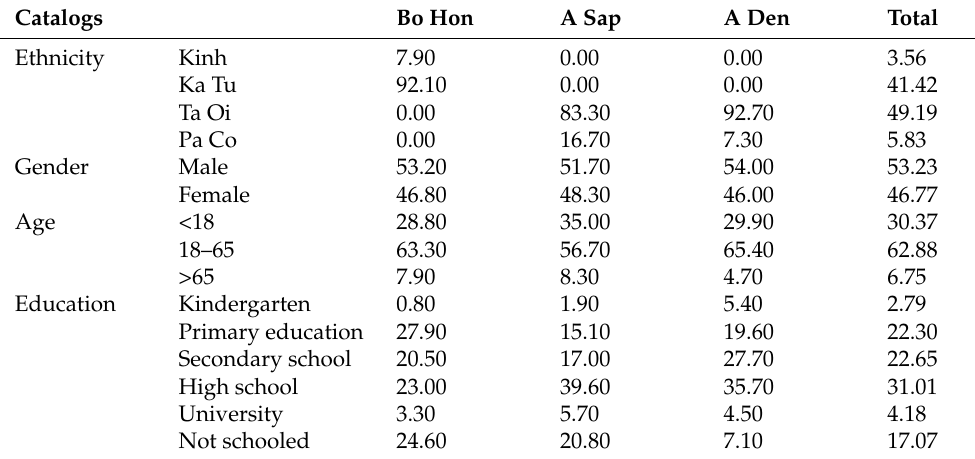
Table 1. Some demographic characteristics of surveyed households ( unit :